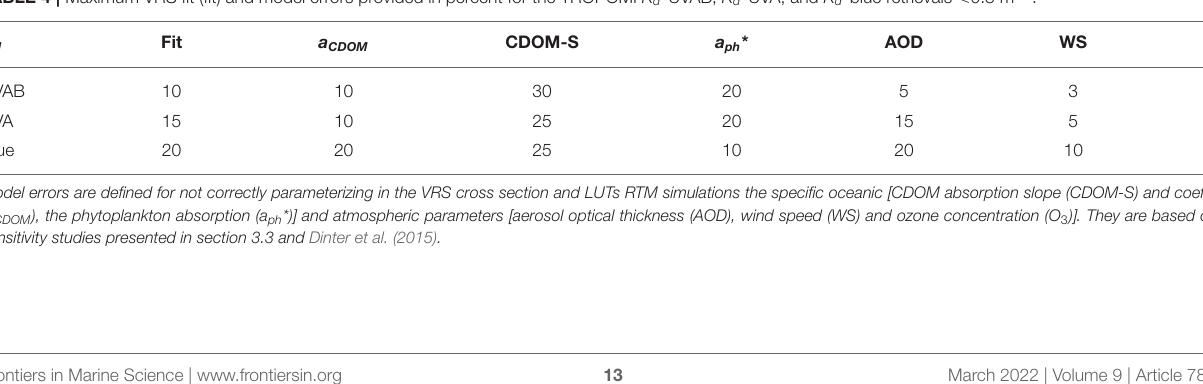
TABLE 4 | Maximum VRS fit (fit) and model errors provided in percent for the TROPOMI K d -UVAB, K d -UVA, and K d -blue retrievals < 0.3 m − 1 . K d Fit a CDOM